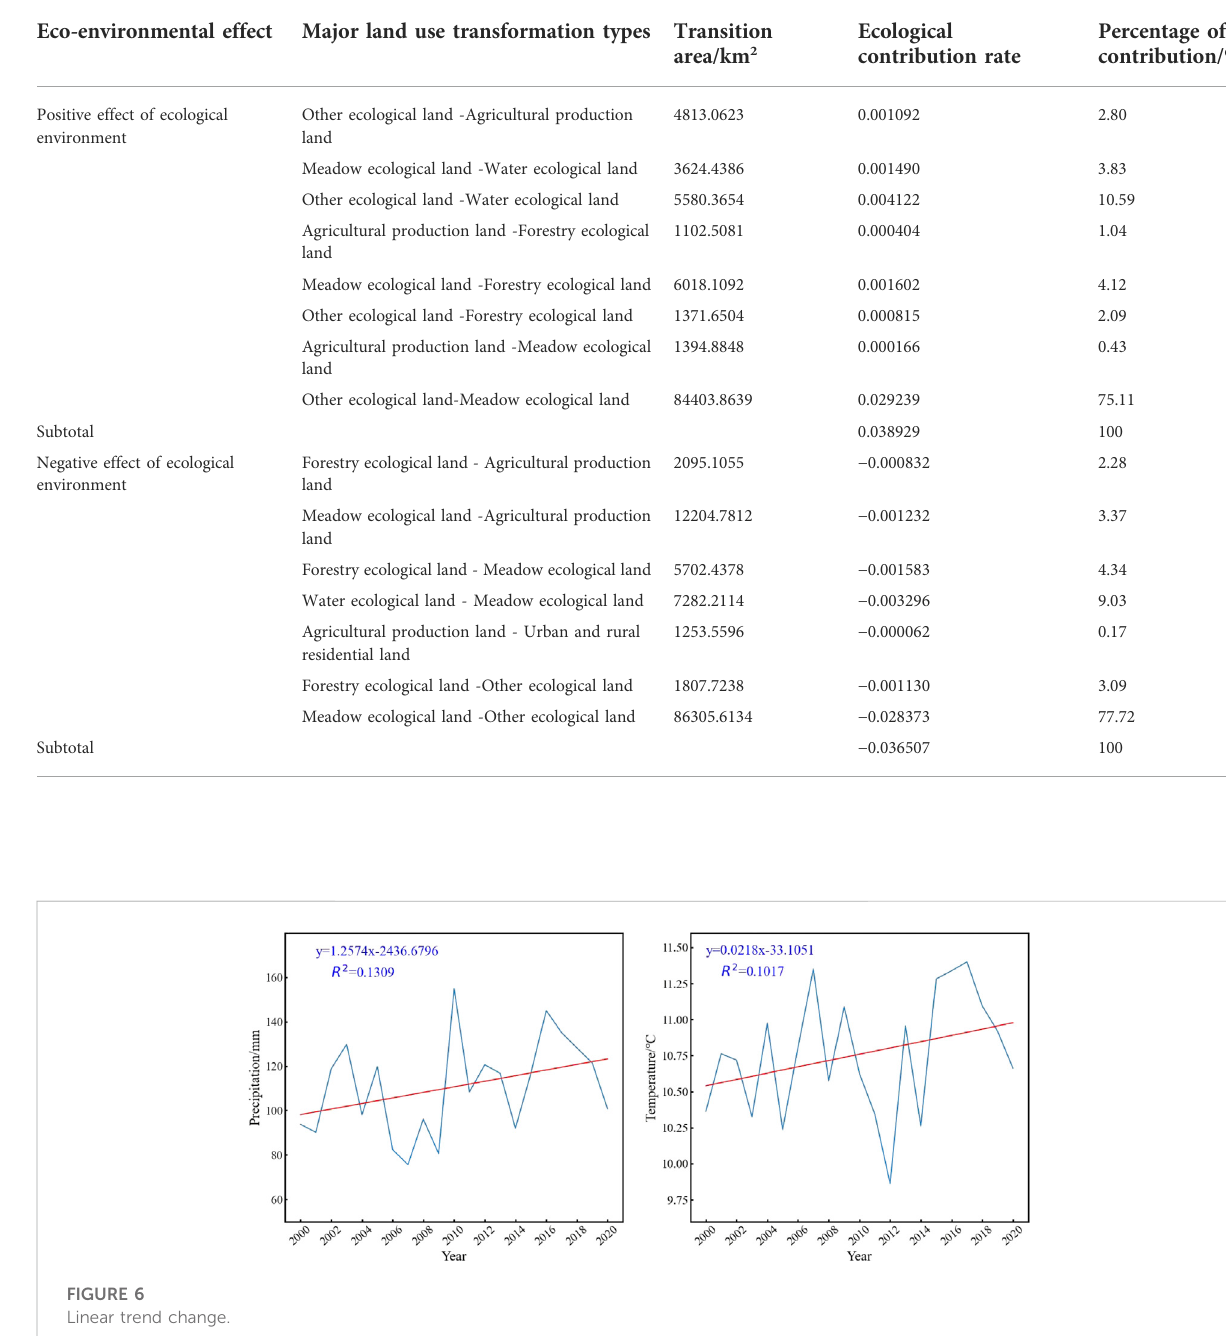
TABLE 4 Land type transformation and contribution rate to PLES in the Tarim River Basin in 2000 – 2020.